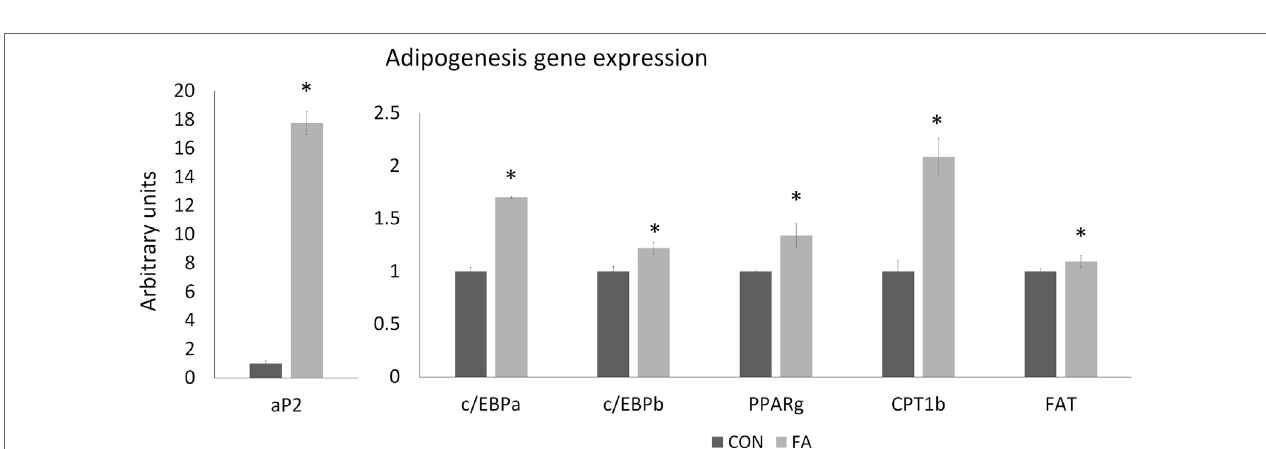
FigUre 2 | The relative gene expression related to myogenesis of C2C12 cells in control (CON) and EPA/DHA (FA) medium. Data show the change of their mRNA expression in FA group compared with CON group. The relative expressions were calculated in arbitrary units. * P < 0.05 and & P < 0.1; n = 3.